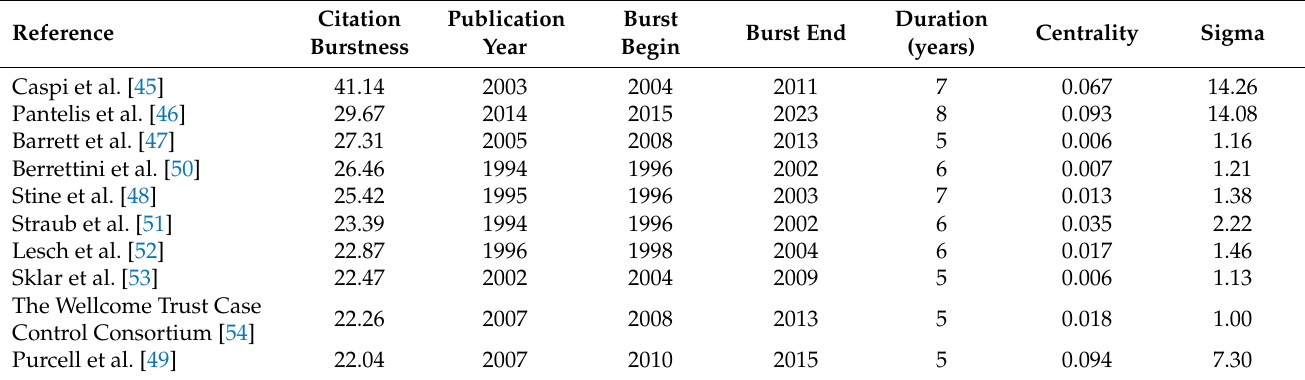
Table 2. Top 10 documents with highest citation